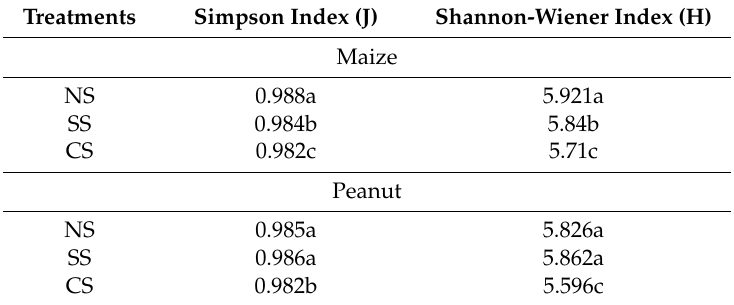
Diversity analysis of rhizosphere soil bacterial communities under different intercropping